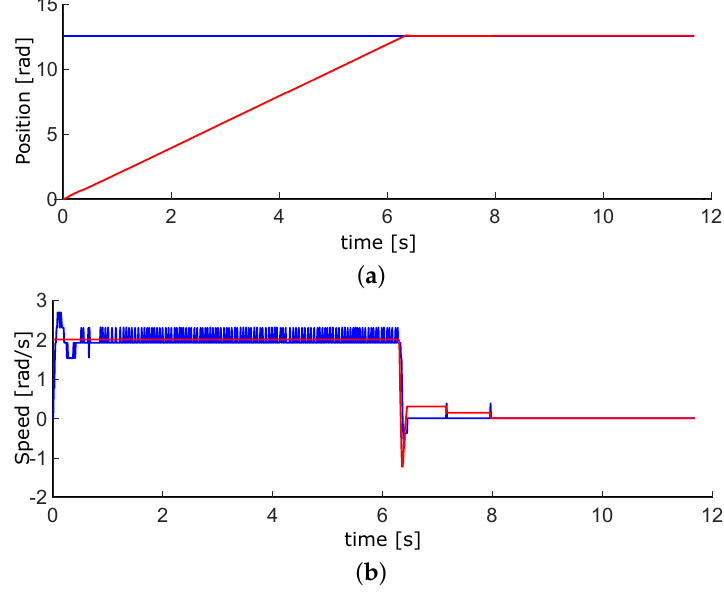
Figure 18. Experimental results for position and velocity control of DC motorswhere the blue lines are the setpoint and red ones the control signals. ( a ) Position plot. ( b ) Velocity